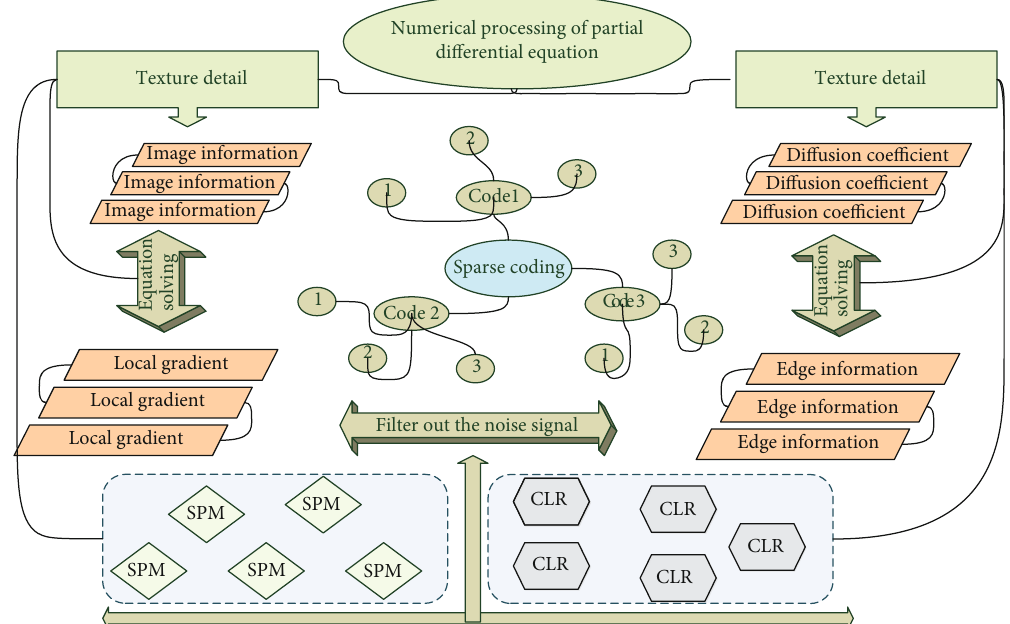
Figure 5: Schematic diagram of the numerical processing e ff ect of partial di ff erential equations.